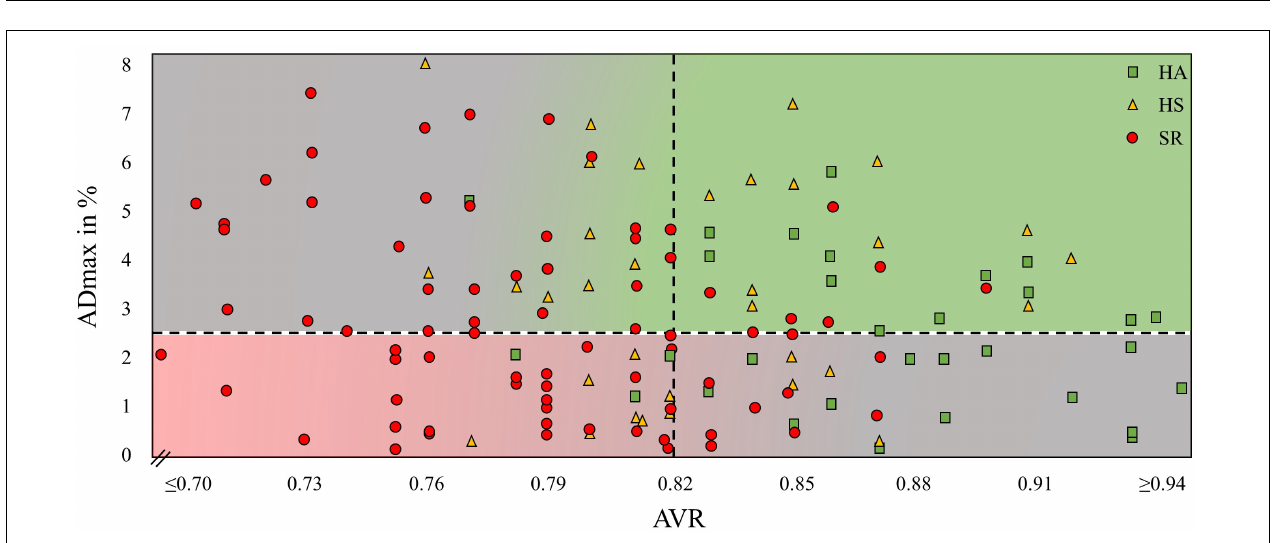
FIGURE 3 | Median arteriolar flicker response in healthy active (blue), healthy sedentary (yellow) and sedentary individuals with increased CV risk (red).